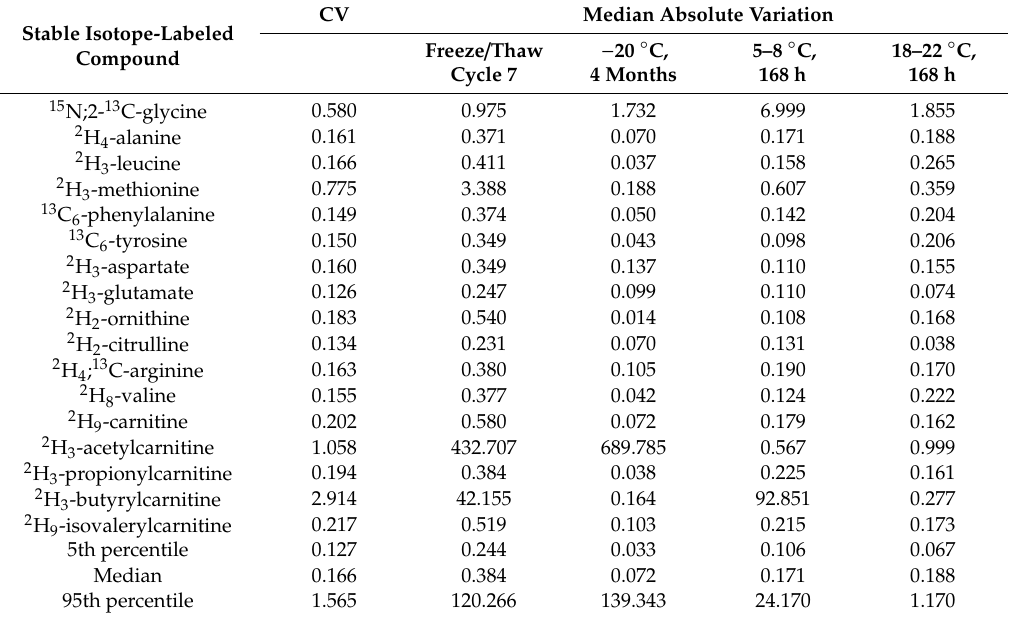
Table 1. Coe ffi cient of variation of the analysis and median absolute variation of stable isotope-labeled compounds for the most extreme storage